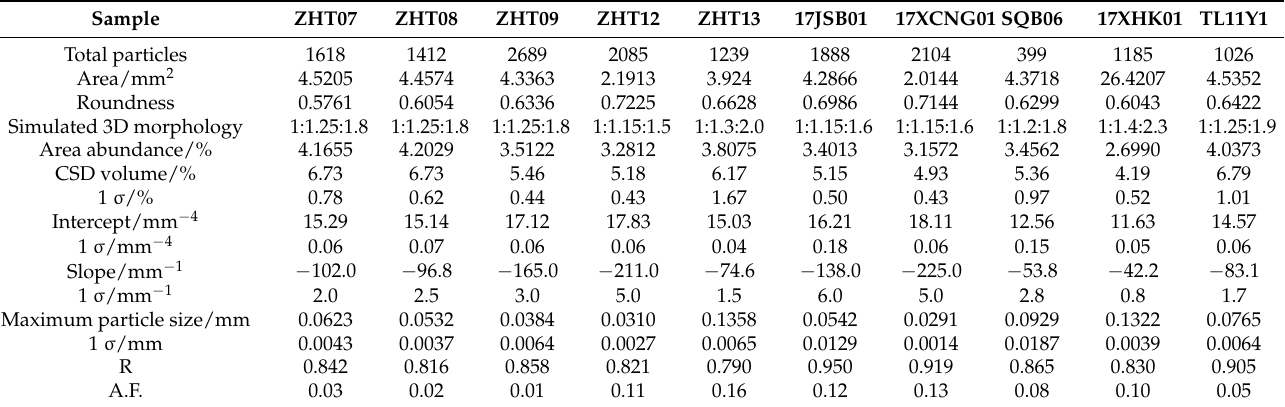
in Figure 5: S-CSD (semilogarithmic CSDs) lines (17JSB01, ZHT07), L-CSD (lognormal CSDs) lines (17XCNG01, SQB06, ZHT08, ZHT09, ZHT12) and F-CSD (fractal CSDs) lines (17XHK01, TL11Y1, ZHT13). Table 2. Titanomagnetite textural parameters of the Hannuoba alkaline basalt